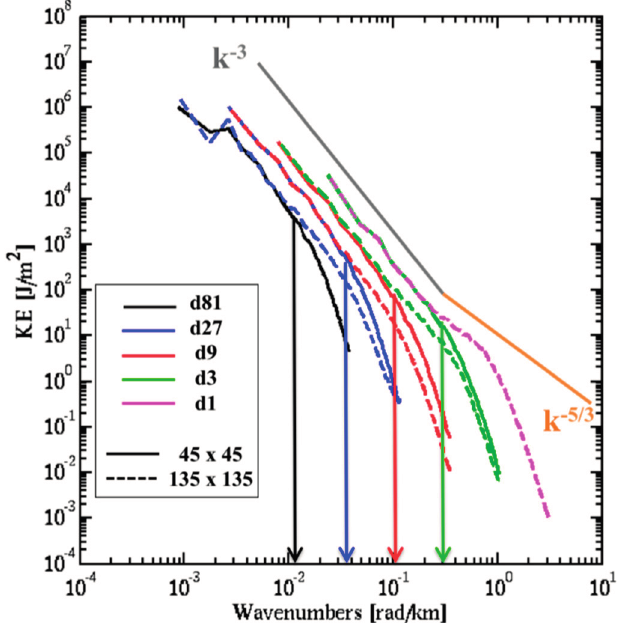
Figure 4. Kinetic energy (KE) spectra for the d81 (black), d27 (blue), d9 (red), d3 (green) and d1 (pink) simulations. The abscissa represents the wavenumbers (rad/km), and the ordinate is the KE (J/m 2 ), vertically averaged from 700 to 200 hPa and temporally averaged over the period from 0000 UTC 13 February to 0000 UTC 1 March 2002. The solid lines correspond to domains covering the inner 45 × 45 grid points, and the dashed lines correspond to the same spatial coverage in the next higher closest resolution (135 × 135 grid points). The arrows show the estimated effective resolution for each simulation. The grey and orange lines are the k − 3 and k − 5/3 characteristic spectral slopes,